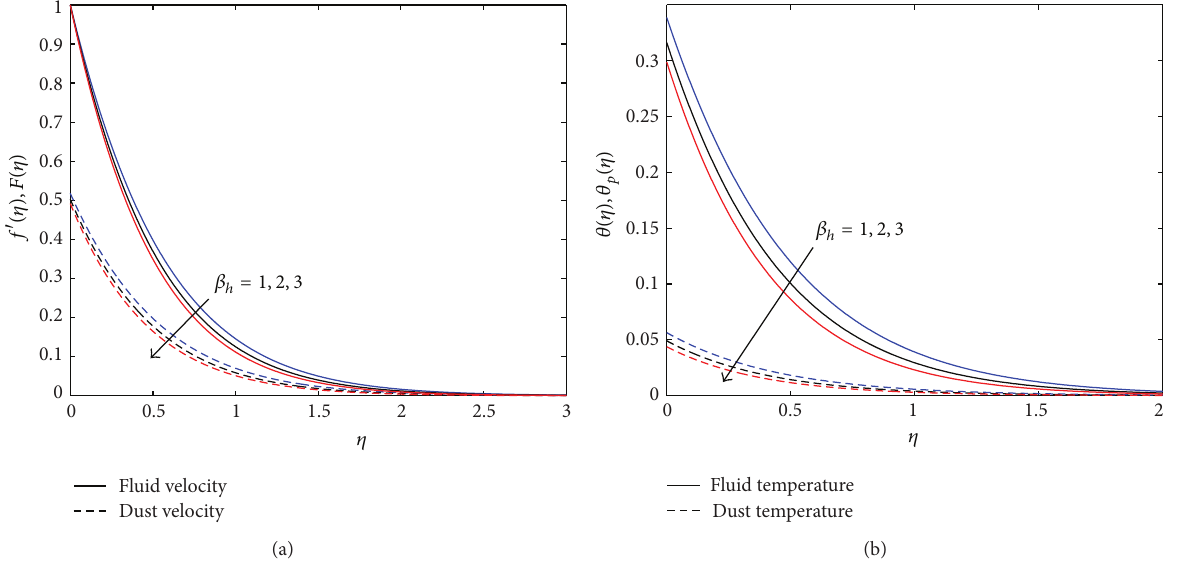
Figure 4: Effect of 𝑆 on (a) 𝑓 󸀠 , 𝐹 and (b) 𝜃 , 𝜃 𝑝 when 𝑀 = 1 , 𝑆 = 2 , 𝑁 = 1 , Bi = 1 , and Ec = 0.1 .